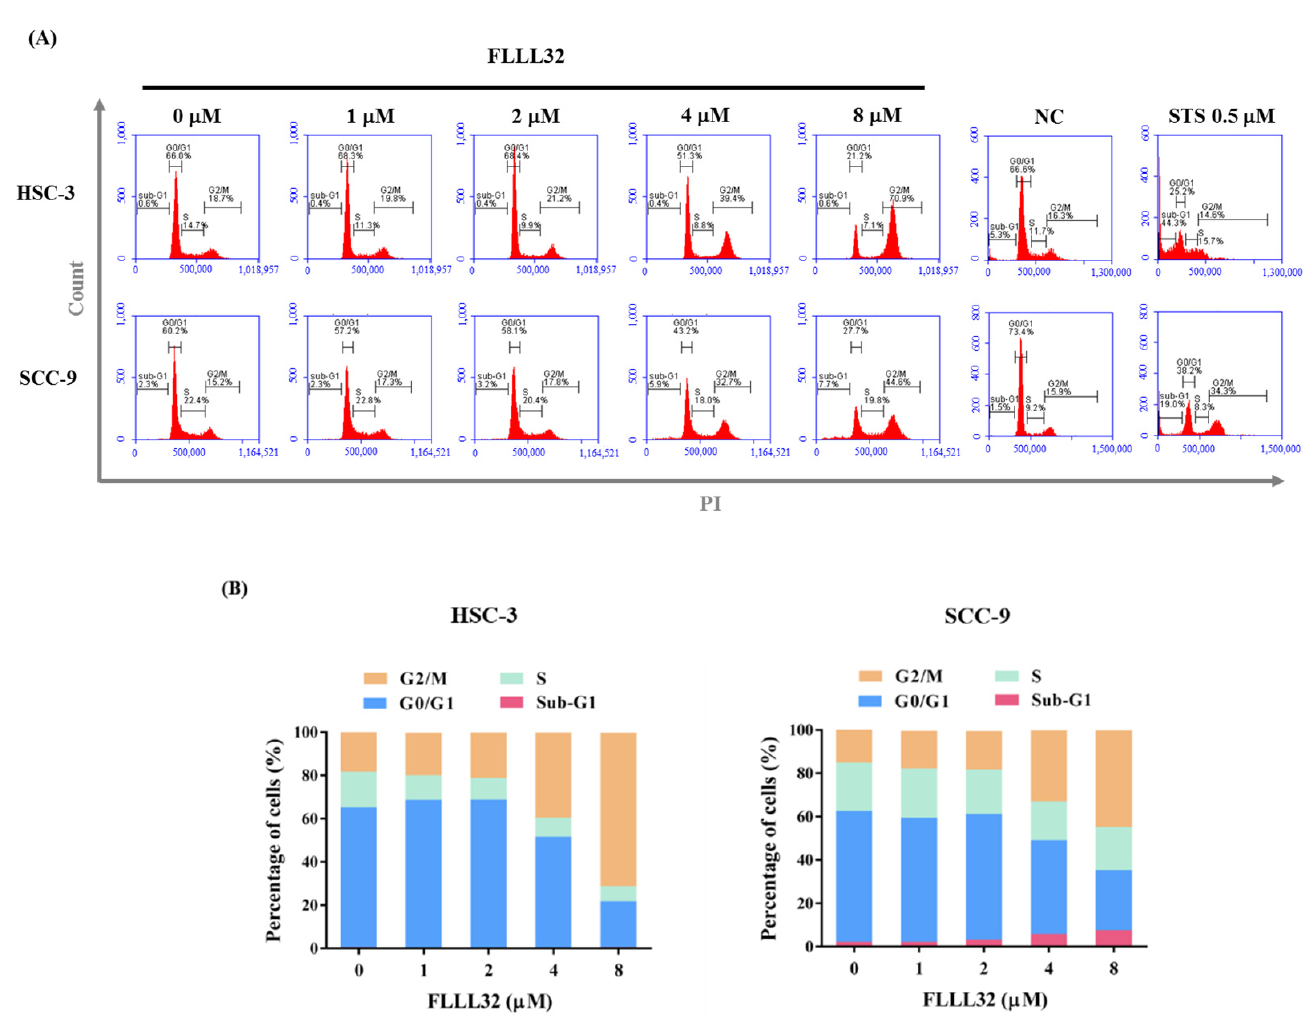
Figure 2. FLLL32 causes G2/M arrest in oral cancer cells. ( A ) HSC-3 and SCC-9 cells were treated with 0, 1, 2, 4, or 8 µ M FLLL32 for 24 h and then stained with PI. The distribution of each cell phase was analyzed by flow cytometry. NC: negative control; STS: staurosporine. ( B ) The quantitative cell-cycle phase distribution indicated that G2/M arrest was caused by FLLL32 in HSC-3 and SCC-9 cells in a dose-dependent manner.